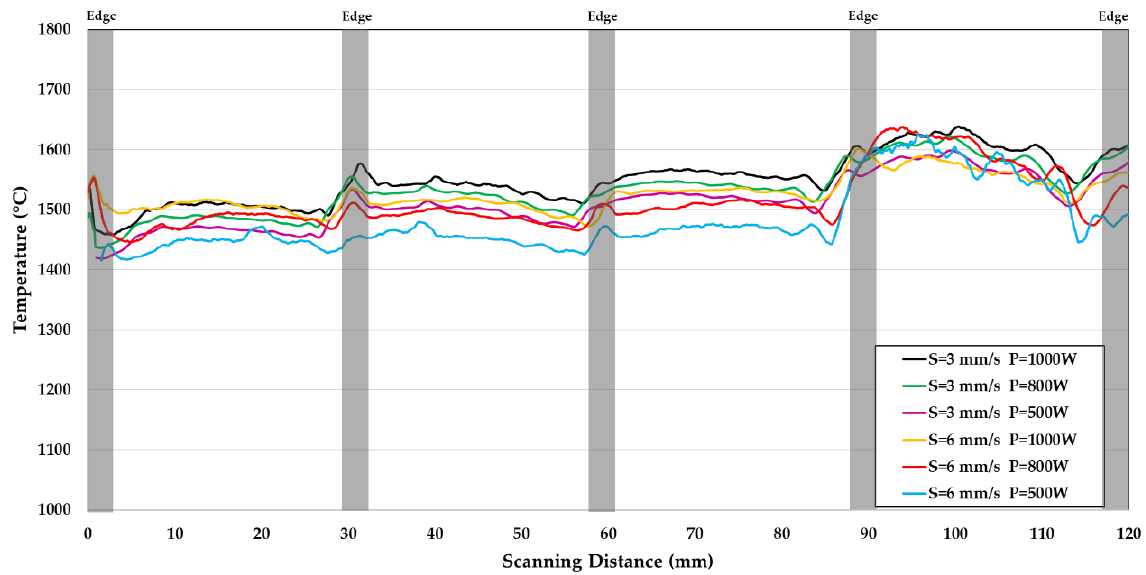
Figure 7. Temperature converted from infrared images during laser cladding for different laser powers and scanning speeds.